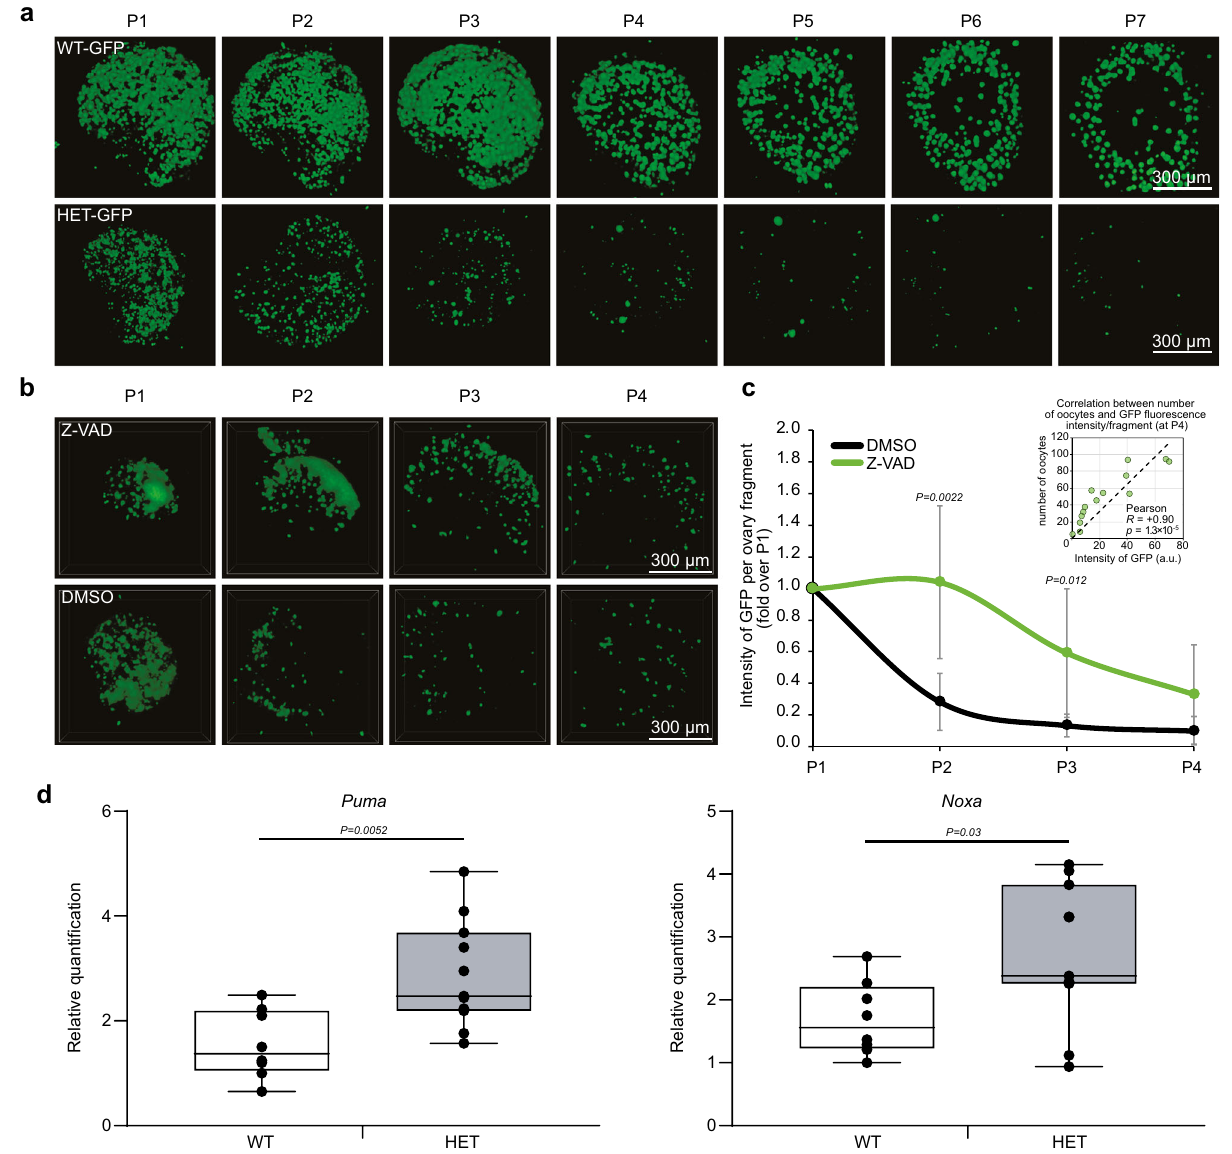
Fig. 3 The Δ 13p63 heterozygous oocytes died by apoptosis. a Time-course (P1 – P7) confocal imaging of the entire ovaries from WT-GFP and HET Δ 13p63-GFP (indicated as HET-GFP in fi gure) mice showing 3D rendered reconstructions using an alpha-blending algorithm. Oocytes were labelled by the expression of p-70/c-Kit fused to GFP. Images were acquired with a step distance of 5 µ m. b Confocal imaging of ovarian fragments from heterozygous mice, performed as described in a . Ovaries were divided into two fragments at P1 and treated with either DMSO or 50 µ M Z-VAD for three days. c Intensity of GFP/ovary fragment at P1, P2, P3, P4 in presence or absence of Z-VAD (50 µ M). n = 7 (DMSO) and n = 7 (Z-VAD) ovary fragments were analysed. Data are presented as mean ± SD, * p -value by two-tailed unpaired Student ’ s t -test. Correlation between GFP fl uorescence intensity and oocytes number (P4) is shown in the scatterplot in the upper right corner. Pearson correlation (R), between GFP fl uorescence intensity/fragment and oocytes number (P4) and p -value are shown ( n = 7 (DMSO) and n = 7 (Z-VAD) ovary fragments); d Boxplots showing Puma and Noxa expression quanti fi cation by RT-qPCR in P1 ovaries of WT ( n = 9) and HET ( n = 9) mice. The centre of the boxplots represents median, boxes represent fi rst (25%) and third (75%) quartiles, whiskers extend to the most extreme datapoints that are no more than 1.5-fold of the interquartile range from the box. Single values are plotted as individual points. p -value by two-tailed unpaired Student ’ s t -test. The images shown are representative of all the experiments performed (at least n = 3) Source data are provided as a Source Data fi different mutations have been reported to affect female fertility causing either POI (R555 * , W559 * ) 39,40 , premature menopause (delC1783) 38 or complete absence of ovaries (delTT1576) 37 . The common feature of those frameshifts and nonsense mutations is the heterozygous loss of the TID, similar to our HET Δ 13p63 mouse model. Within the ELA and AEC/RHS syndrome families many more mutations affecting the p63 C-terminus have been identi fi ed, but so far their effect on female fertility has not been categories: point mutations within the DNA-binding domain